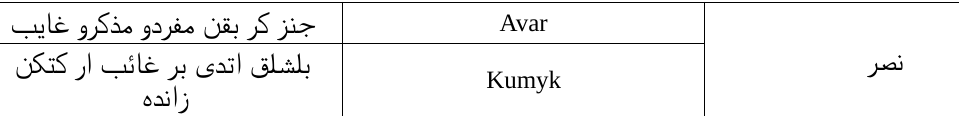
Table 1 - Samples of verb conjugation (the Arabic verb رصن ) in the Kumyk and Avar